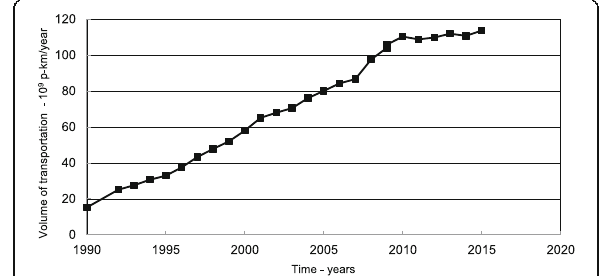
Fig. 1 Development of the volumes of passenger transportation in